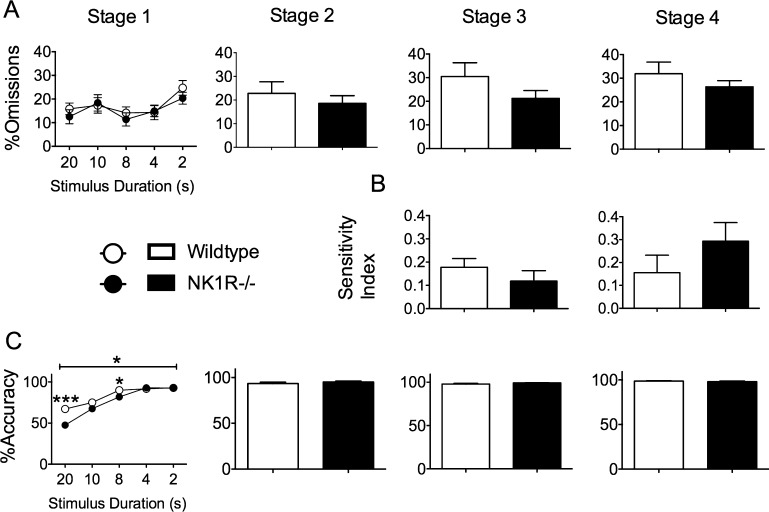
Attention in the 5C-CPT: NK1R−/− mice were less accurate than wildtypes at the onset of training in the 5C-CPT. Circles/bars show mean ± s.e.m. For Stages 2–4, the bars show data for the first day of training, only. A: %omissions; B: sensitivity index; and C: %accuracy. Numbers on abscissae for Stage 1 specify the stimulus durations (gradually reduced from 20 to 2 s as animals achieved progression criteria). A line above graphs/bar charts indicates an overall difference between NK1R−/− and wildtype mice. Statistical significance of differences between pairs of data (compared by genotype) indicated by: *P < 0.05; **P < 0.01; ***P < 0.001. N = 12 per group.